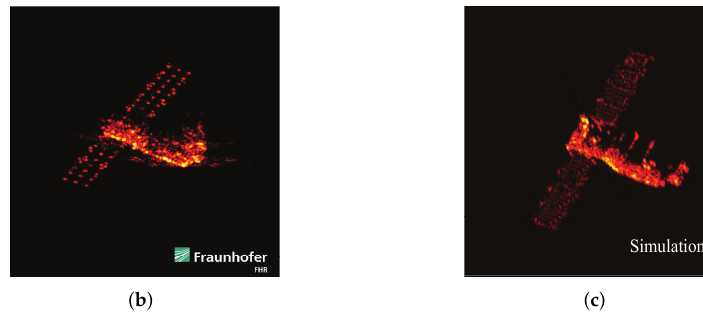
Figure 8. ( a ) The CAD model of TG-I satellite; ( b ) real ISAR image; and ( c ) EM simulation ISAR